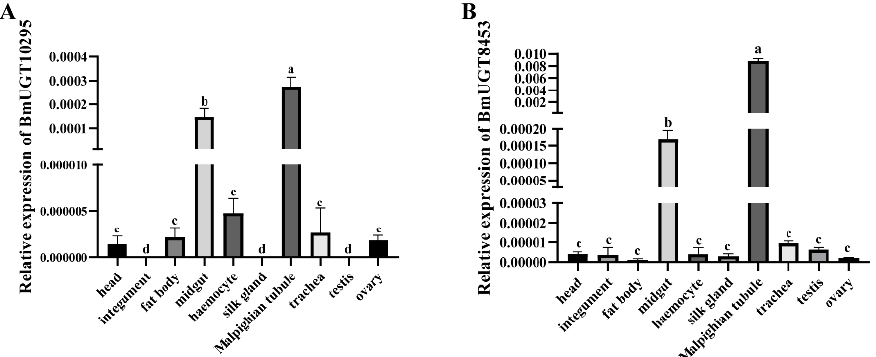
Figure 2. Spatial expression patterns of infected B. mori . Day 1 fifth instar Bombyx mori that were infected with Nosema bombycis. The relative expressions of BmUGT10295 ( A ) and BmUGT8453 ( B ) were assessed in different tissues of silkworms 3 days after infection. The relative gene expression levels were estimated according to the 2 − ∆ Ct method. sw22934 was used as an internal reference. Bars represent the mean of three individual measurements ± SD. Statistical analysis was conducted by one-way ANOVA using a Tukey’s multiple comparison test. Identical letters indicate no significant difference ( p > 0.01), whereas different letters indicate a significant difference ( p <